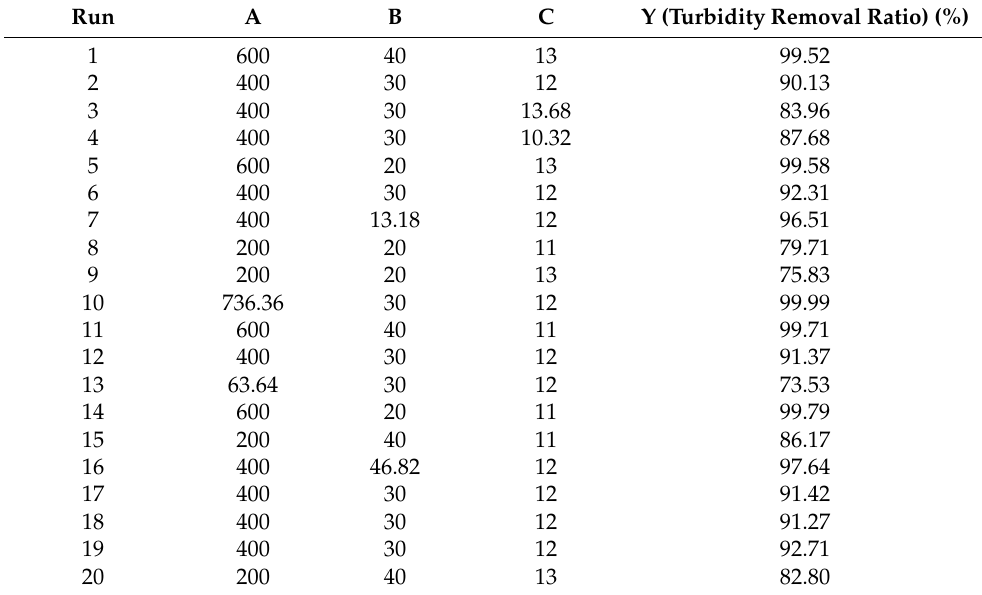
Table 2. Experiment and results designed by